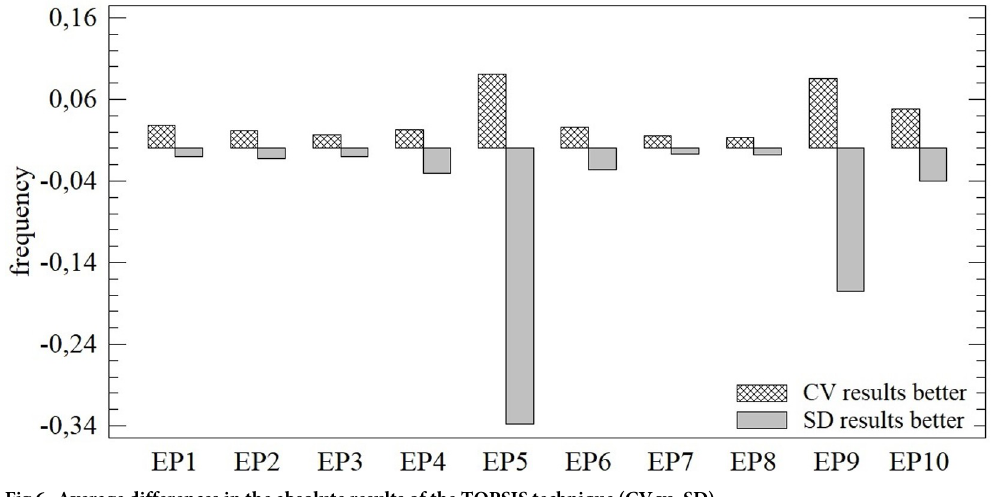
Fig 6. Average differences in the absolute results of the TOPSIS technique (CV vs. SD).